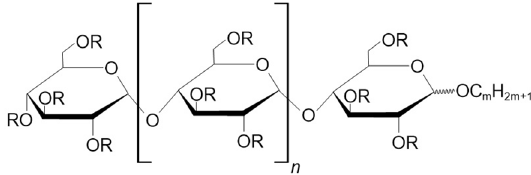
Figure 4. The general structure of sulfated alkylmaltooligosaccharides. R is SO 3 Na or H. The number n varies from 2 to 5 and the number m varies from 12 to 18 [48].